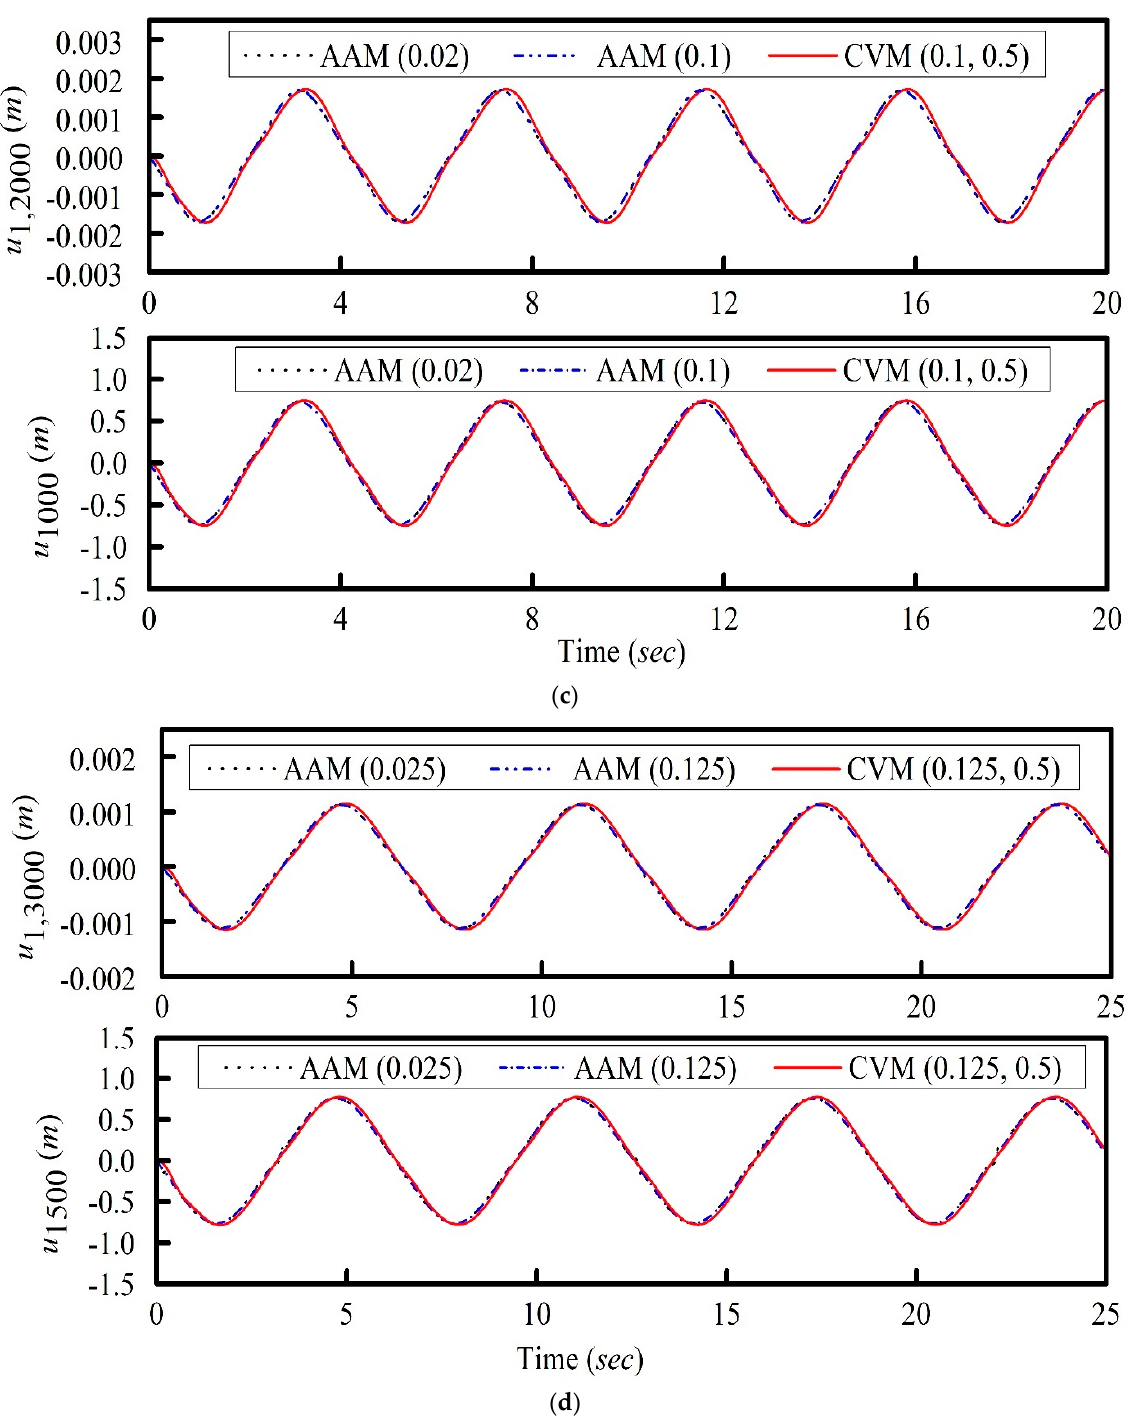
Figure 20. Displacement responses for the spring mass system: ( a ) 500-DOF, ( b ) 1000-DOF, ( c ) 2000-DOF and ( d ) 3000-DOF.